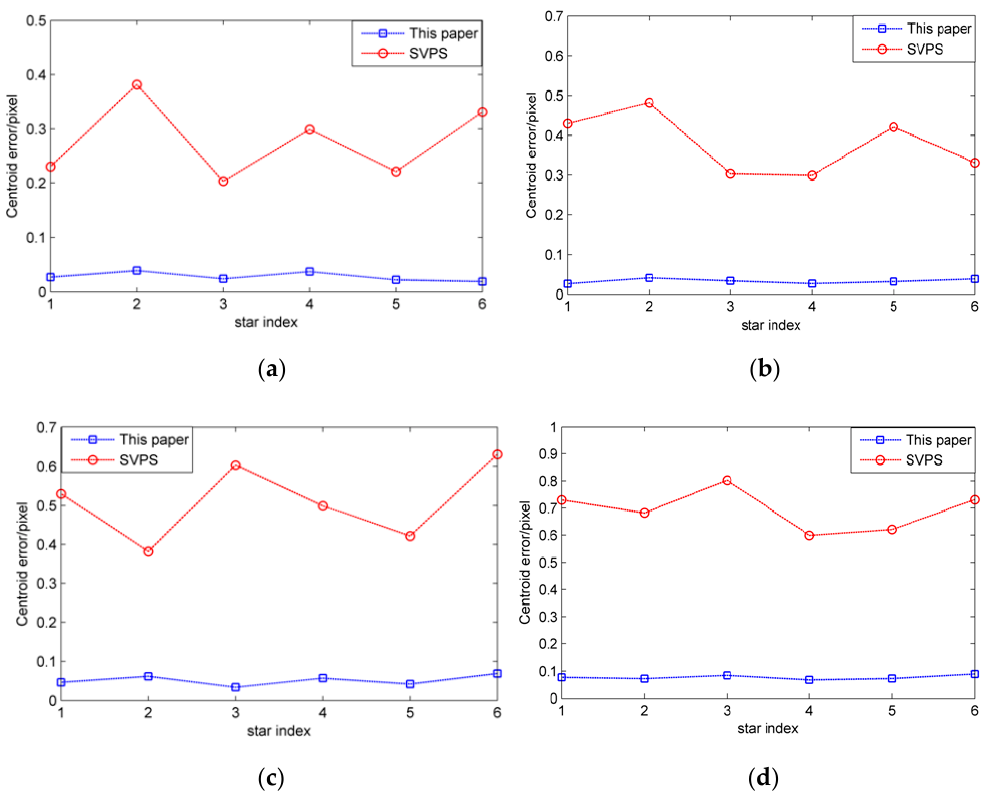
Figure 16. Star centroid errors under different angular velocity. ( a ) Star centroid errors in first frame; ( b ) star centroid errors in second frame; ( c ) star centroid errors in third frame; ( d ) star centroid errors in fourth frame. Table 5. Processing time of restoration